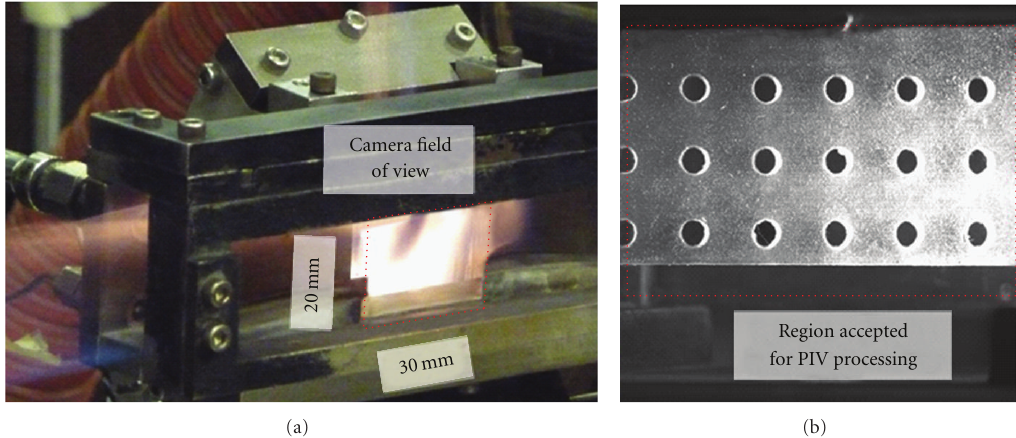
Figure 4: Approximate camera field of view on the UCC (a); calibration image showing region of image used for PIV processing (b).